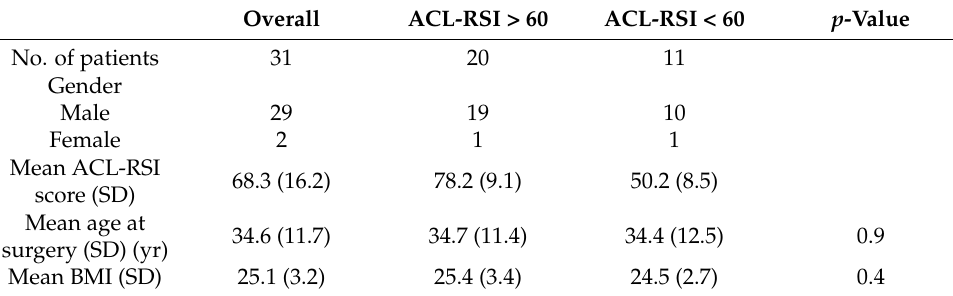
Table 1. Patient demographics and anthropometric data. Overall